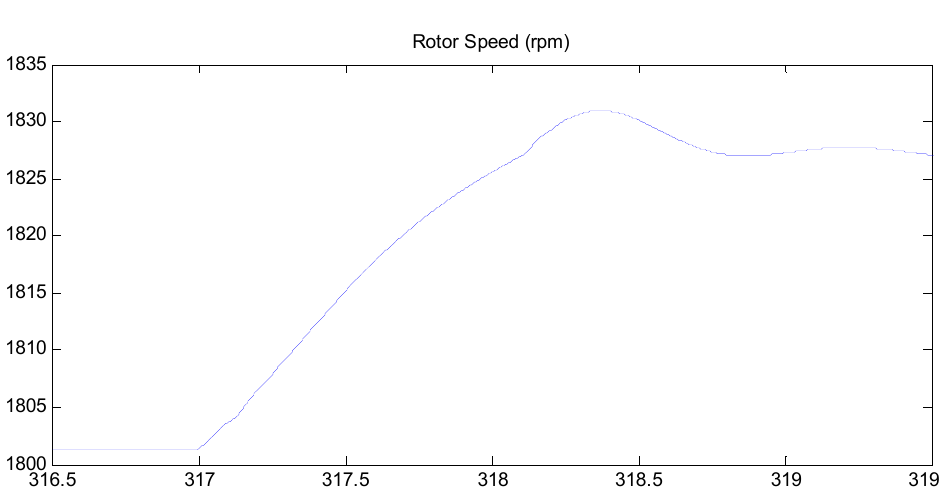
Figure 11. Rotor speed (rpm) vs. time (s) during voltage